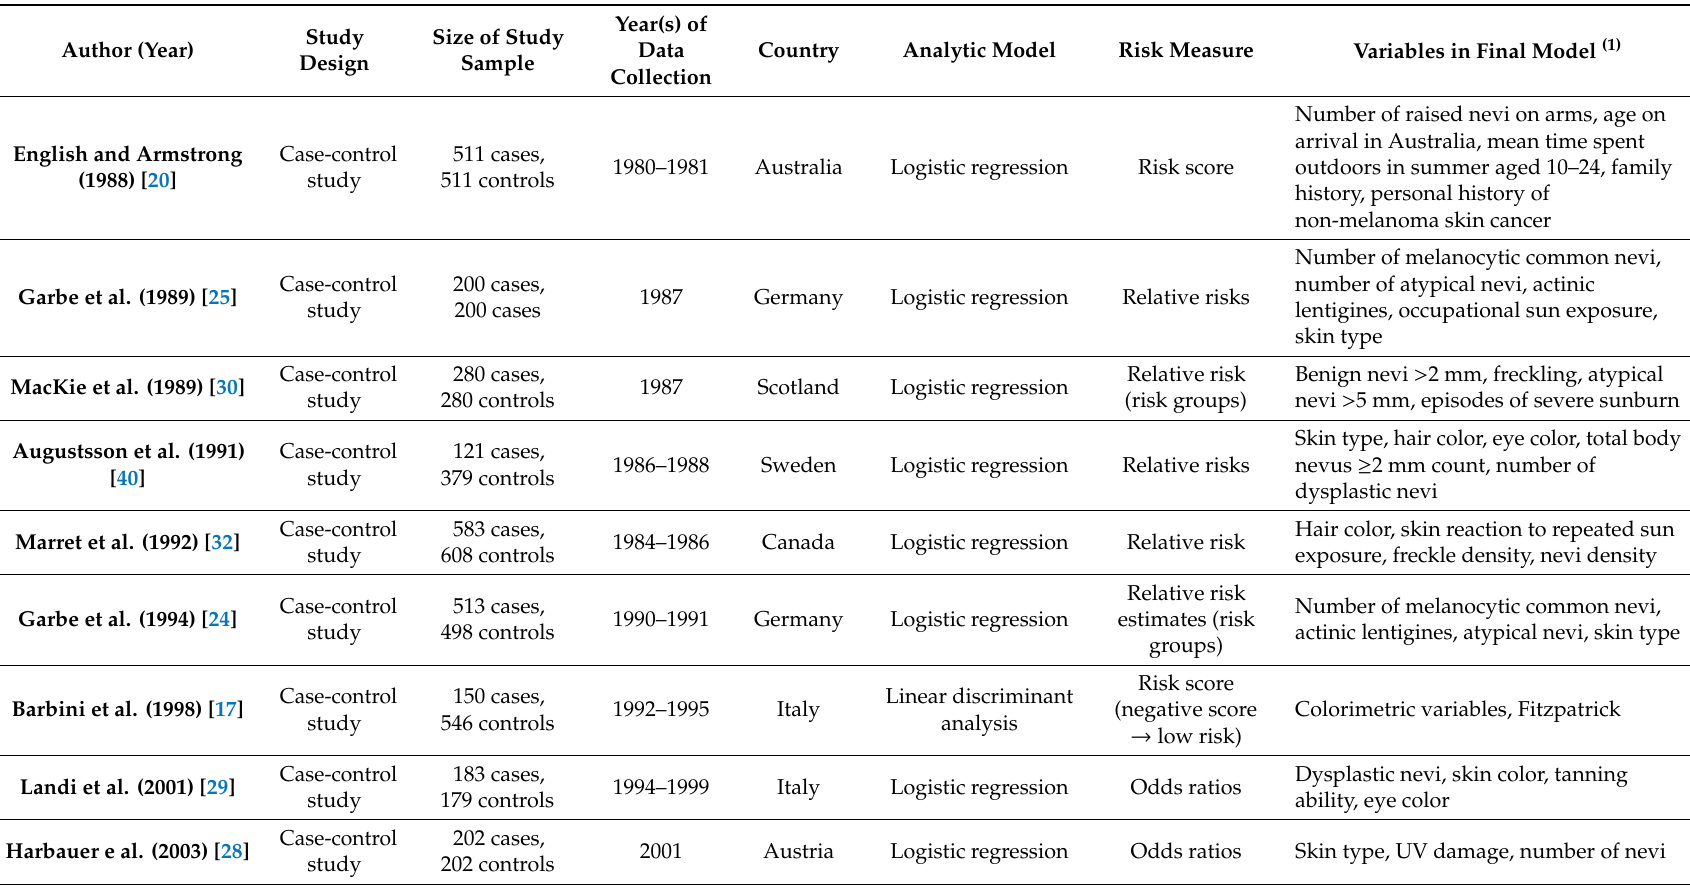
Table A1. Basic characteristics of studies reporting risk prediction models for melanoma. Studies are ordered according to year of publication. ( N = 40